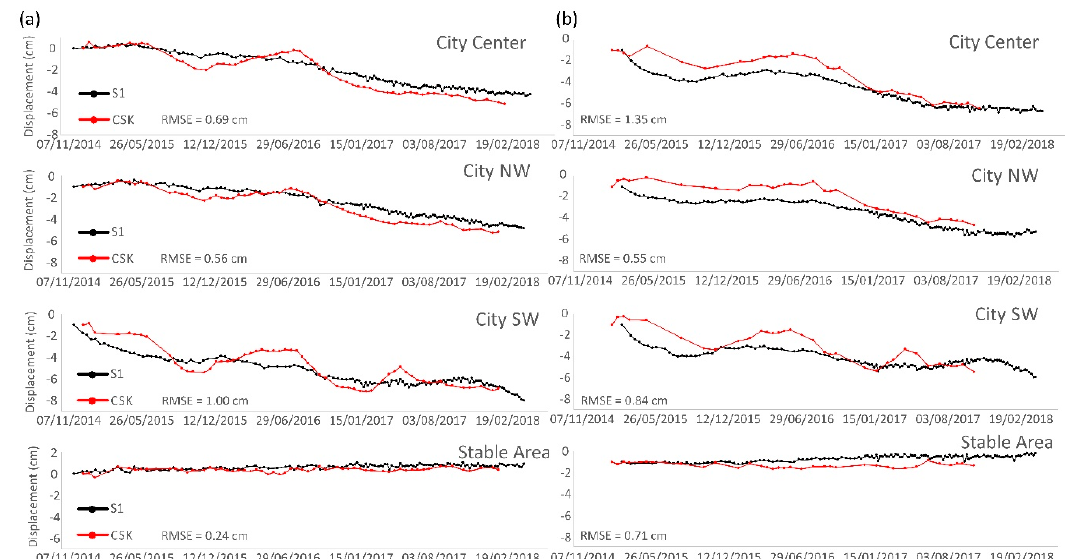
Figure 4. Ascending ( a ) and descending ( b ) time series over the main deformation areas. These points are located in Figure 3a. The stable area is outside of the main area of interest. The good agreement between CSK and S-1 time series lead to a reinterpretation of the deviation